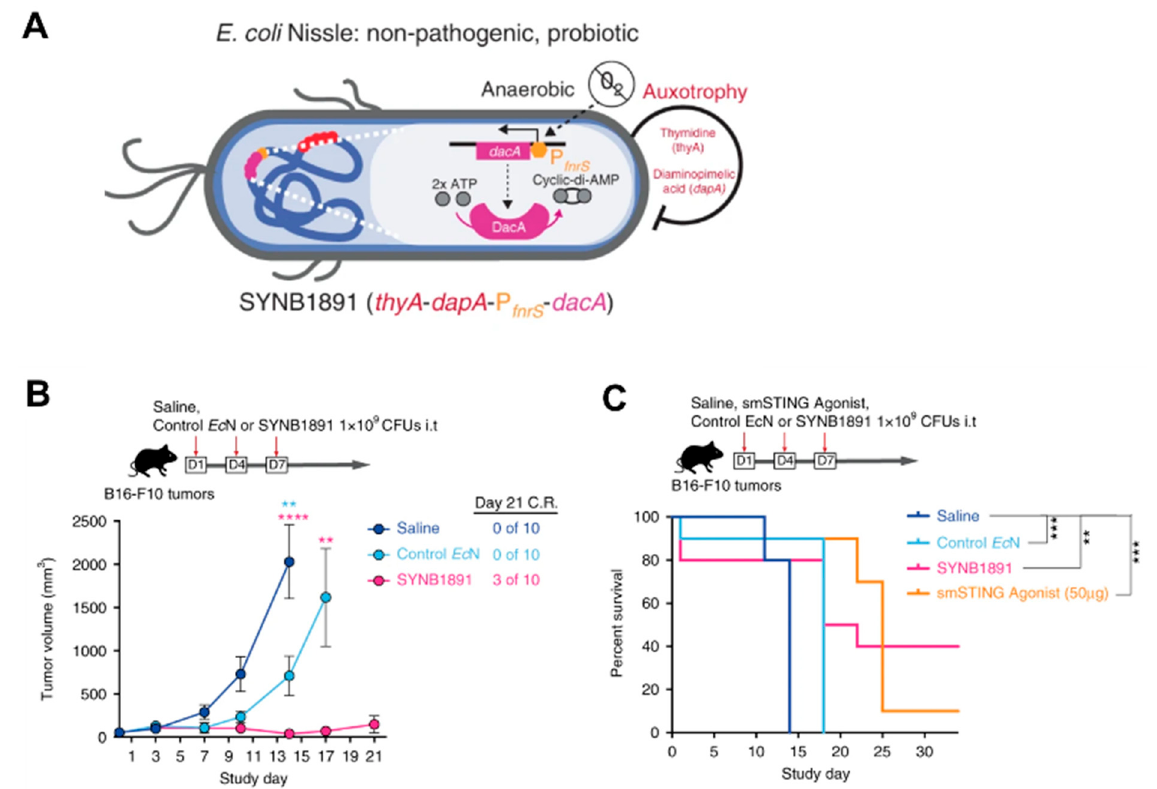
Figure 4. ( A ) Schematic illustration of the engineering EcN strain named SYNB1891; ( B ) Tumor inhibition and ( C ) survival rates of SYNB1891 treatment in B16F10 tumor-bearing mice. Reproduced with permission from Jose M. Lora, Nature Communications; published by Springer Nature, 2020. ** p = 0.0058 (blue stars), **** p < 0.0001 (pink stars), ** p = 0.0078 (pink stars), ** p = 0.006 (black stars), *** p = 0.0004–0.0006 (black stars).